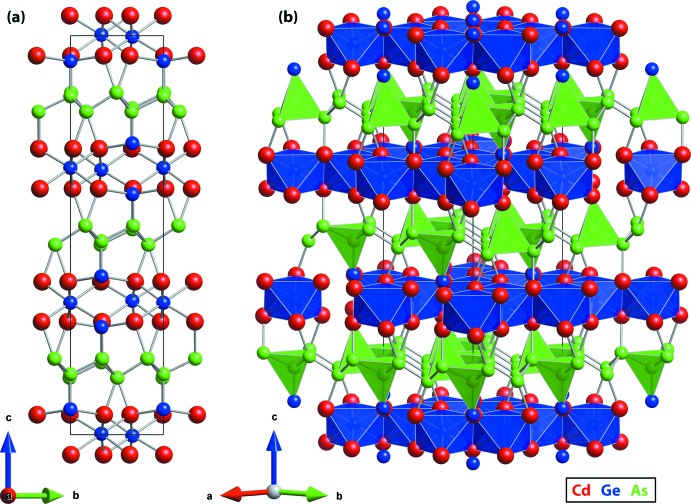
Crystal structure of the Cd3Ge2As4 showing (a) the distribution and linkages of atoms and (b) the layer structure composed of GeAs4 tetra­hedra and GeCd6 octa­hedra; the legend is shown in the bottom right (Cd = red, Ge = blue, As = green). The reader is referred to the online version for reference to color.